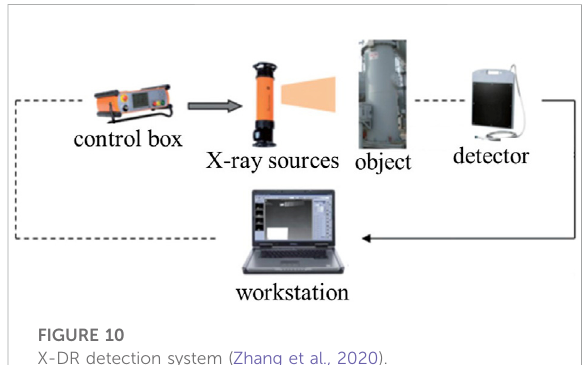
FIGURE 10 X-DR detection system (Zhang et al., 2020).